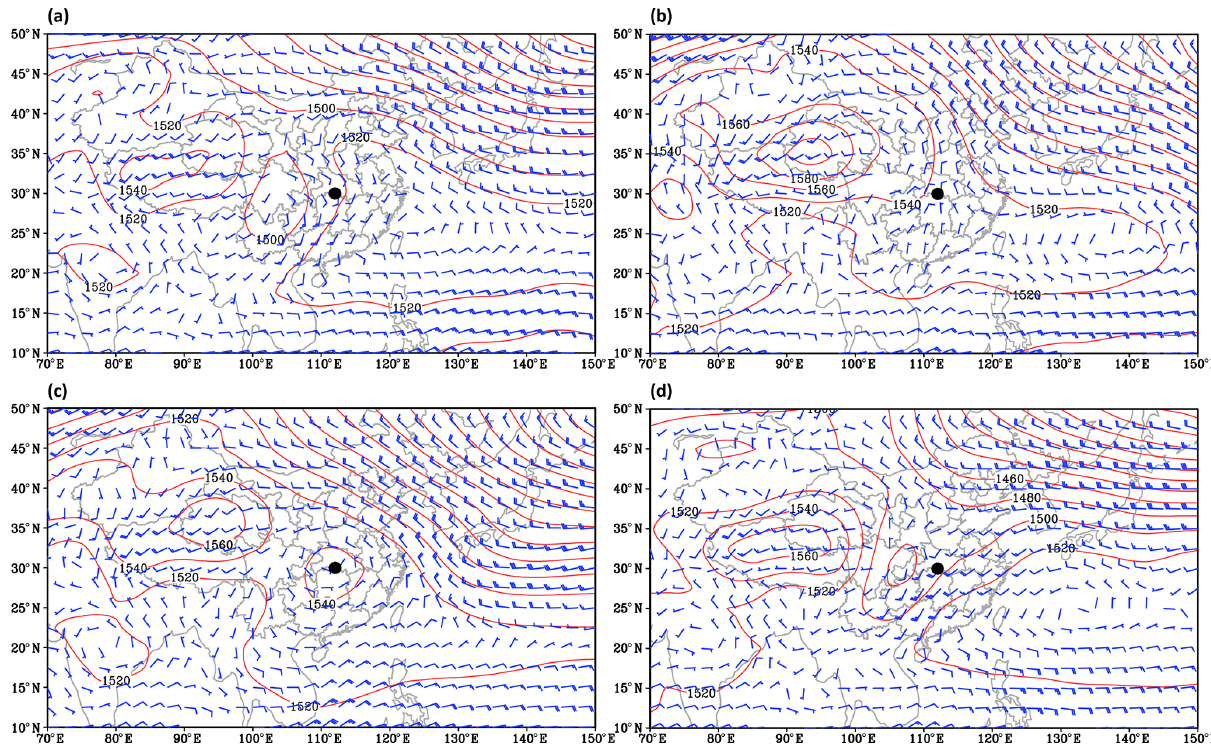
Figure 3. Spatial distribution of 850hPa geopotential height and wind vector for SW-type (a) , NW-type (b) , A-type (c) , and C-type (d) synoptic control averaged over 2013–2018. The black dot indicates the location of